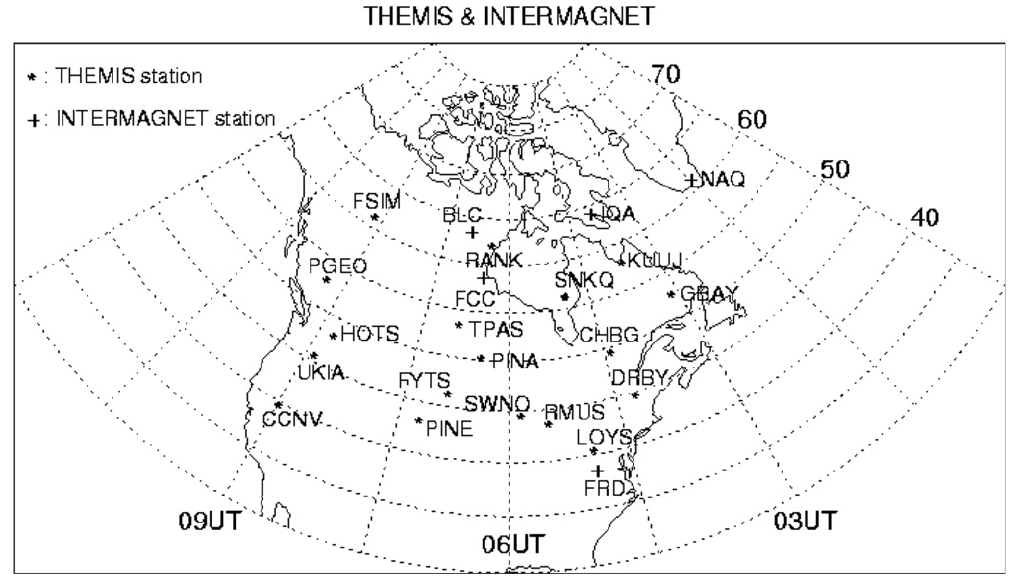
Fig. 1. The locations of the ground-based observatories for the THEMIS mission and four INTERMAGNET observatories for this study. The sign + denotes the INTERMAGNET observatory with a three-letter abbreviation and the sign ∗ the THEMIS station with a four-letter